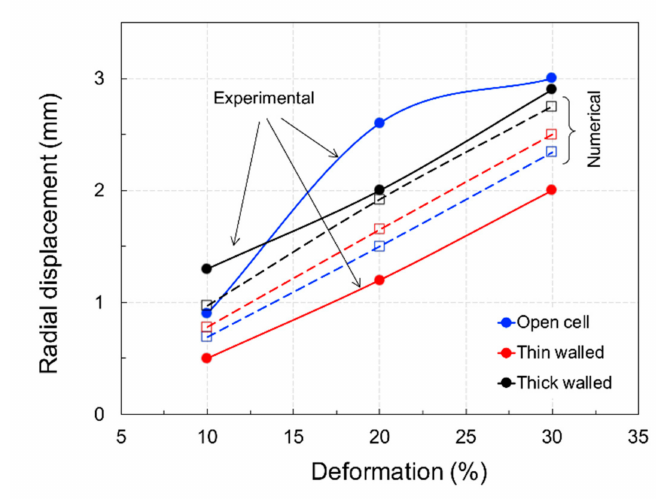
Figure 13. Experimental and numerical radial dilatation of